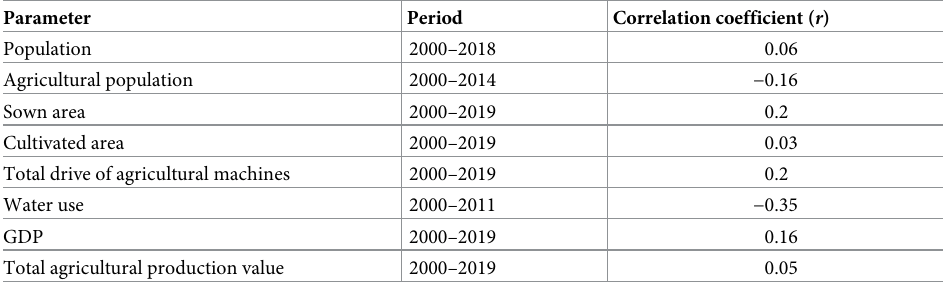
Table 4. Correlation results between river length and anthropogenic disturbances in the Keriya River Basin.